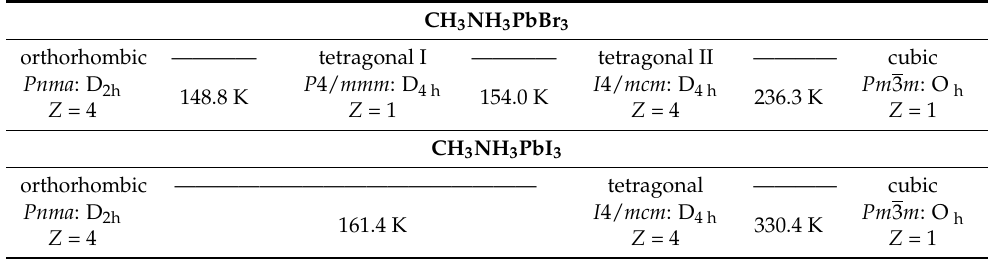
Table 1. Crystal structures [9–11] and transition temperatures [13] of CH 3 NH 3 PbX 3 (X = I,